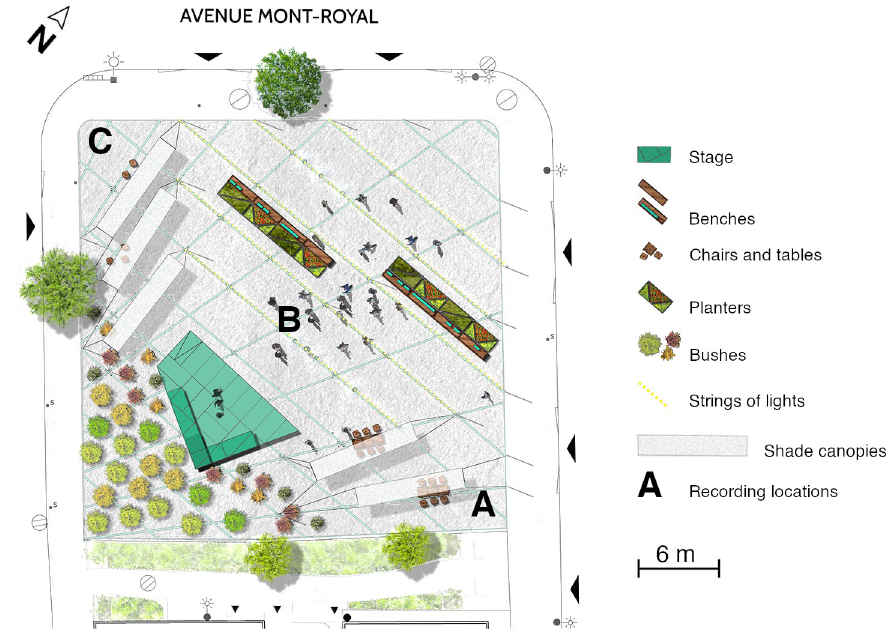
Fig 1. Simplified map of the study site, showing recording locations A, B, and C. Design layout provided by design firm Castor et Pollux and used and edited with permission.